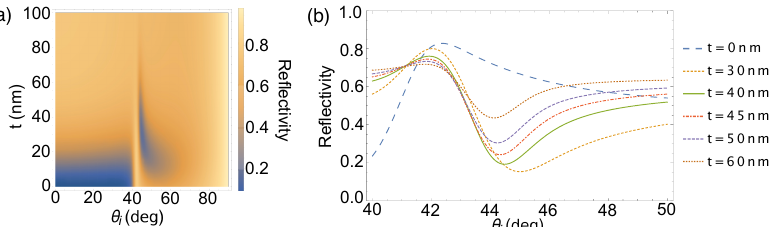
Figure 3. ( a ) Angular reflectivity spectra for a BK7/Ti/Au/air structure at varying Au film thick- nesses with the incident beam tightly focused to a waist radius of 5.28 µ m for an angular range from normal incidence to grazing incidence; and ( b ) the representative plots at several Au thicknesses.